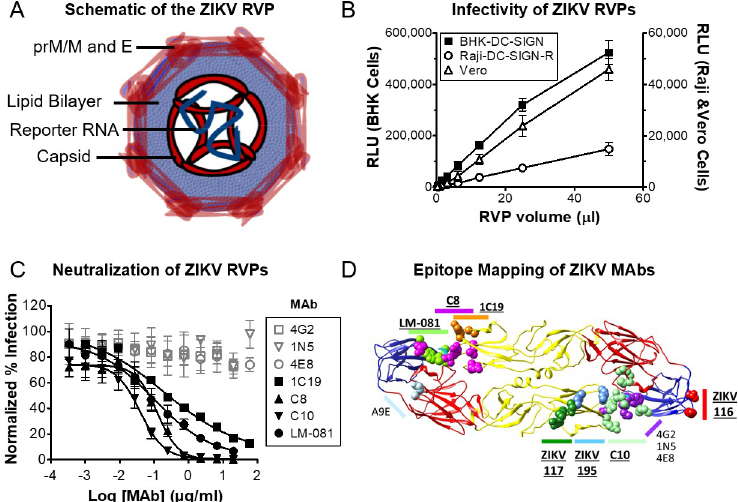
Fig 1. ZIKV RVPs are infectious and antigenically equivalent to live Zika virus. (A) Schematic of the ZIKV RVP, composed of capsid, prM/M, and E proteins from a defined ZIKV strain (SPH2015), and an RNA reporter genome replicon. (B) Luciferase ZIKV RVPs were tested for infectivity with cell lines that are commonly used for flavivirus infectivity studies, including BHK-DC-SIGN, Vero, and Raji-DC-SIGN-R cells. At 72 h after infection, cells were lysed and analyzed for luciferase activity (RLU). Values for BHK-DC-SIGN cells (filled symbols) are plotted on the left y- axis. Values for Raji-DC-SIGN-R and Vero cells (open symbols) are plotted on the right y-axis. All values represent n = 3 replicate wells, and error bars represent SD. Regression analysis indicates a linear relationship for the three datasets with RVP volume (R 2 > 0.99). (C) Serial dilutions of the indicated MAbs were incubated with ZIKV RVPs for 1 h, followed by infection of BHK-DC-SIGN cells. After 72 h, cells were lysed and analyzed for RLU. All neutralization results are shown as normalized % infection (% of luciferase signal in the absence of MAb). For 1N5, 4E8, and 1C19, n = 2 and error bars indicate range. For all other data sets n = 7 or 8 and error bars represent SD. Gray symbols represent non-neutralizing MAbs, black symbols represent neutralizing MAbs. (D) Epitopes of 11 anti-ZIKV MAbs used in this paper, mapped onto the ZIKV structure. MAbs that neutralize ZIKV are indicated in bold and underlined.